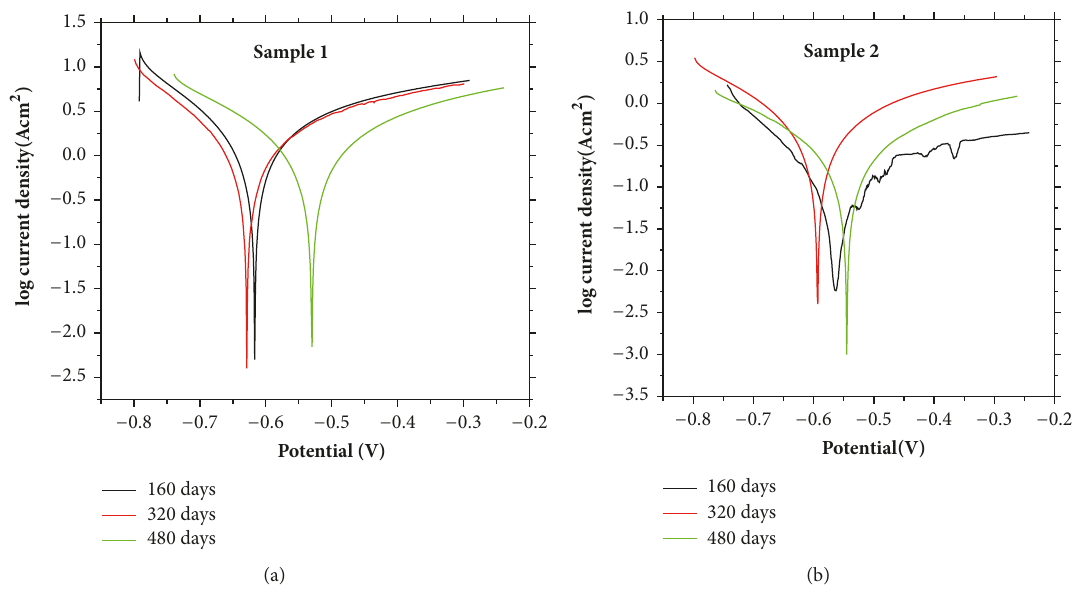
Figure 2: Tafel curves of steel reinforcement in concrete (a) in the absence and (b) presence of SLS for 160, 320, and 480 days. Table 2: EIS parameters of steel reinforcement in concrete in the presence and absence of inhibitor for different periods.